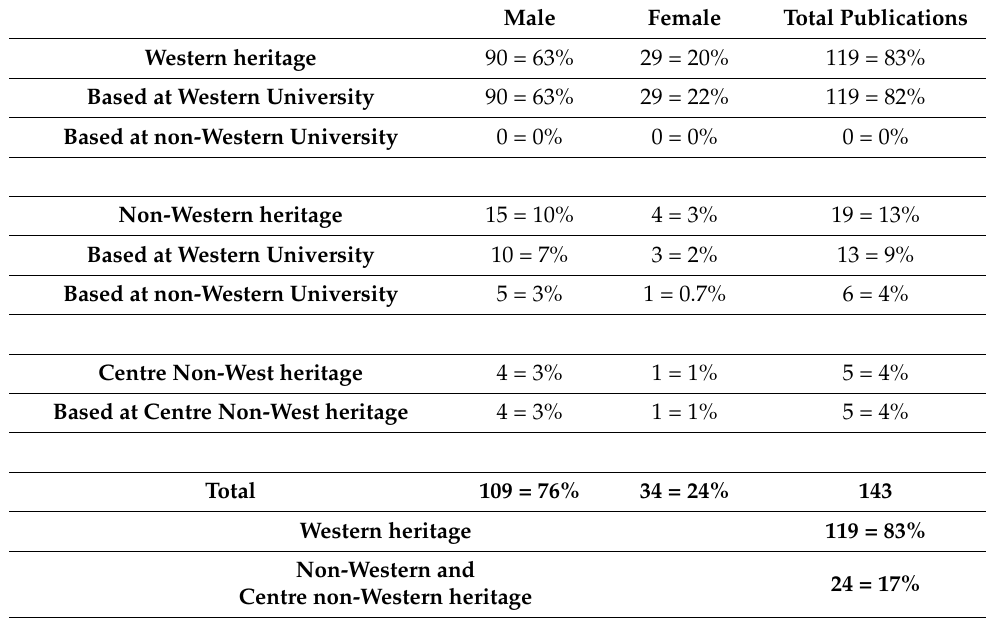
Table A2. Journal of policing, intelligence, and counterterrorism.